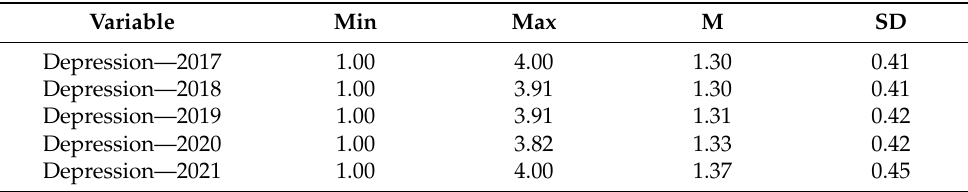
Table 2. Descriptive statistics of depression ( N =